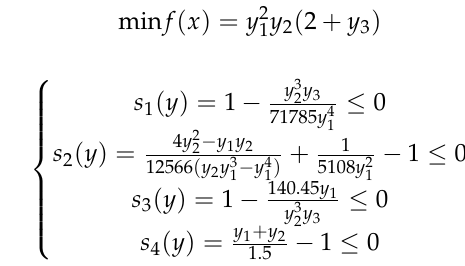
Table 5. The optimal solutions of each algorithm in the stretching/compression spring design prob- lem.